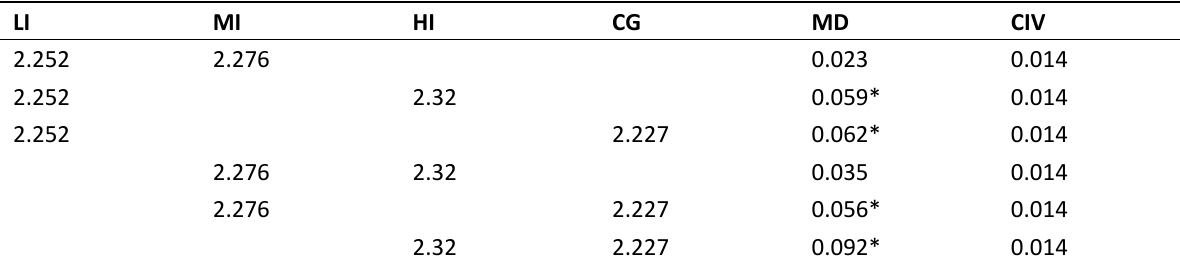
Table 5. Scheffe’s Test showing the differences between paired means of different groups on leg explosive power